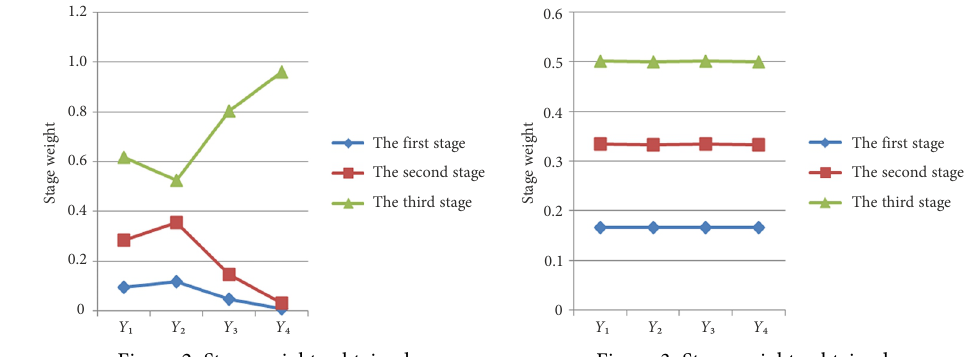
Figure 2. Stage weights obtained by the MAD method